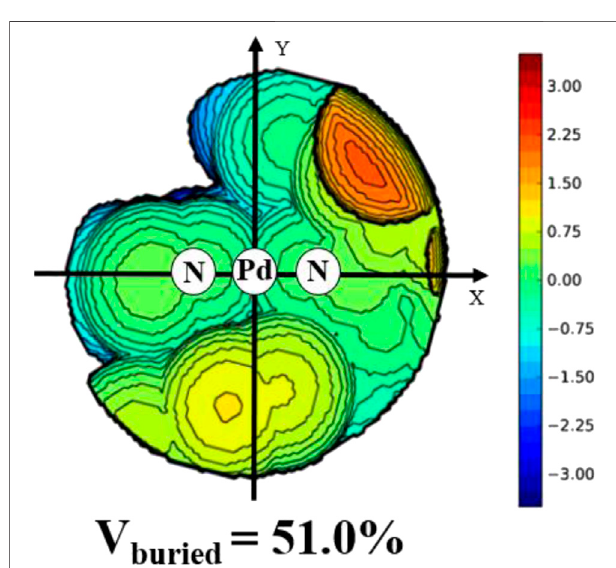
FIGURE 2 | Topographic steric maps of complex Pd5